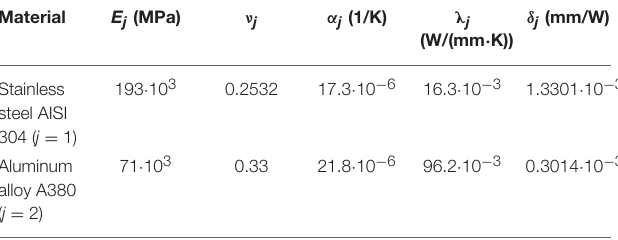
TABLE 1 | The properties of the materials (Harvey, 1982; NADCA, 2015).